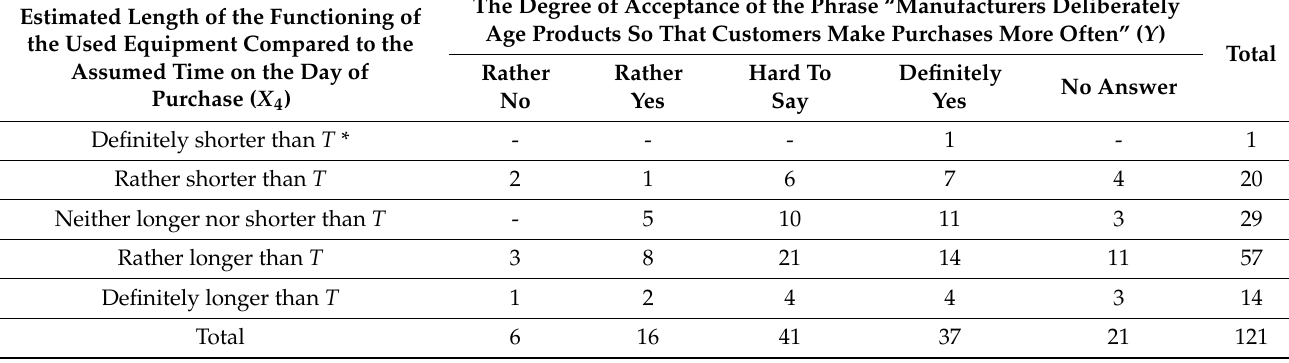
The Degree of Acceptance of the Phrase “Manufacturers Deliberately Age Products So That Customers Make Purchases More Often” ( Y ) Total Rather Rather Hard To Definitely No Answer No Yes Say Yes